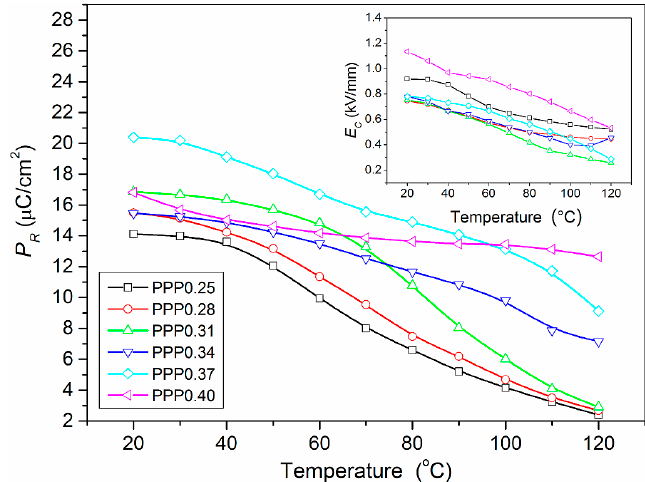
Figure 10. The temperature dependencies of remnant polarization P R and coercive filed E C (inside) for PMN–PT–PS solid solutions.